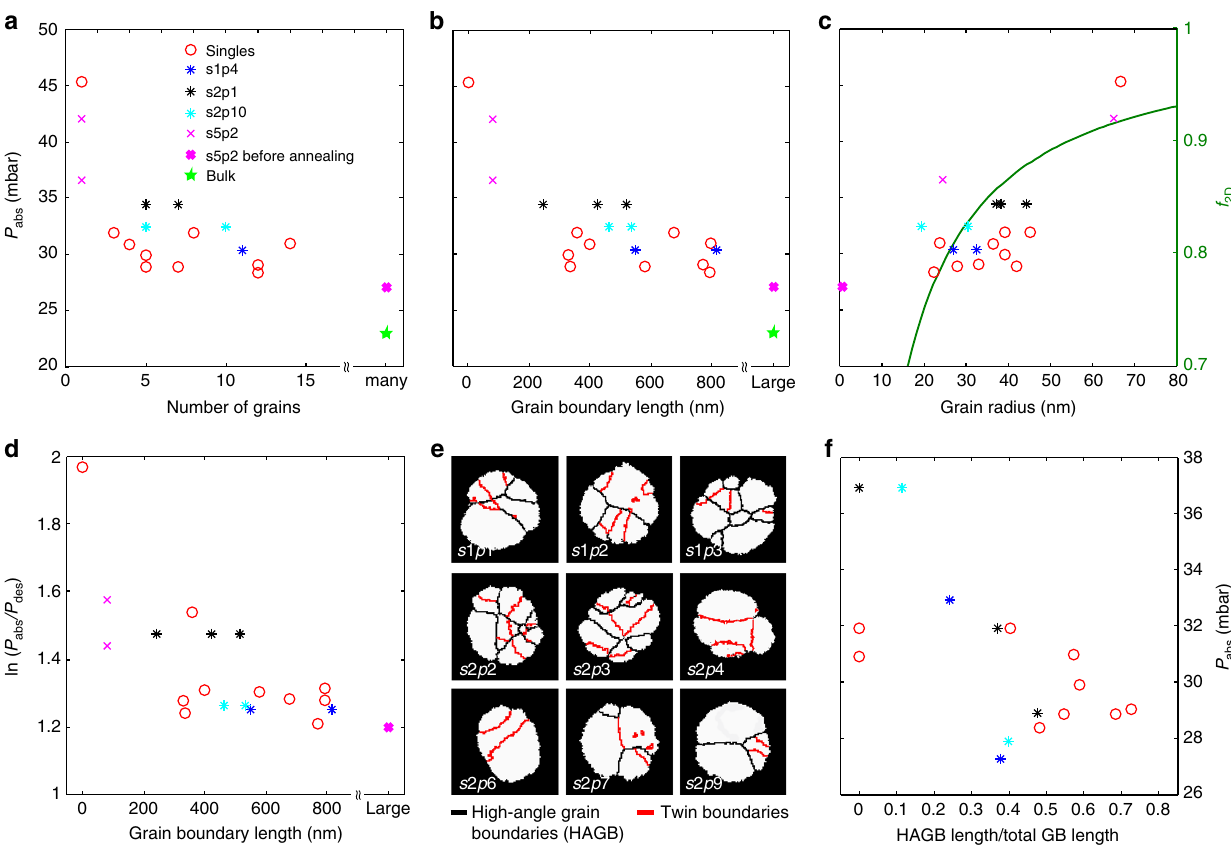
lengthHigh-angle grain boundaries (HAGB) HAGB length/total GB Fig. 6 Grain structure – hydrogenation pressure correlations. The data forming the basis of this fi gure are summarized in Supplementary Table 1. a The equilibrium plateau pressure upon hydride formation measured by plasmonic nanospectroscopy plotted as a function of number of grains. The red circles correspond to data points obtained from single nanoparticles (cf. Fig. 5 and Supplementary Fig. 12). The magenta crosses correspond to the disk-shaped particle shown in Fig. 3d and e, before and after annealing (particle s5p2). The blue , black , and turquoise stars represent averaged plateau pressures for data points corresponding to multiple particles (cf. Supplementary Fig. 13), i.e., particles not resolved in the plasmonic nanospectroscopy experiment. The green star depicts the hydrogenation pressure for bulk Pd obtained by Lässer and Klatt 49 . We refer also to Supplementary Fig. 20 for an alternative representation of the same data. b Equilibrium hydrogenation plateau pressure as a function of grain-boundary length. c Hydrogenation plateau pressure as a function of average grain radius (left y axis). The grain radius was calculated from the TKD images by determining the area of a grain and then taking the radius of a circle with the same area. In the same graph, we also plot the theoretically calculated equilibrium plateau pressure reduction factor for hydride formation, f 2D , ( right y axis) as a function of average grain radius. d Hysteresis factor, ln( P abs / P des ), as a function of grain boundary length. e TKD images of the same nanoparticles shown in Fig. 5, but with grain boundaries highlighted and categorized into high-angle grain boundaries (HAGBs — black lines ) and twin boundaries ( red lines ). f Corresponding plot of HAGB fraction of total grain boundary length vs. equilibrium hydrogenation plateau pressure. The corresponding plots for absolute HAGB length and twin-boundary length are shown in Supplementary Fig.